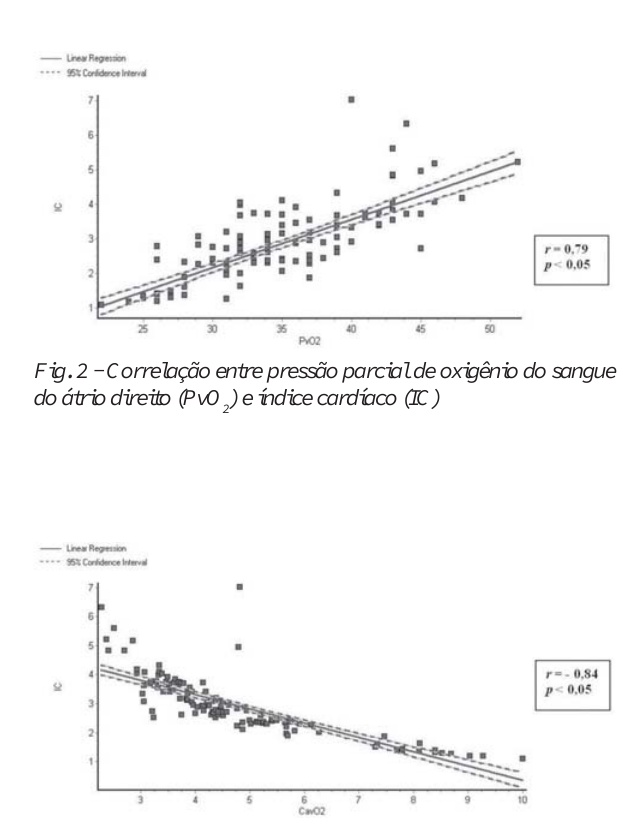
Fig. 3 - Correlação entre diferença do conteúdo artério-venoso de oxigênio (CavO ) e índice cardíaco 2